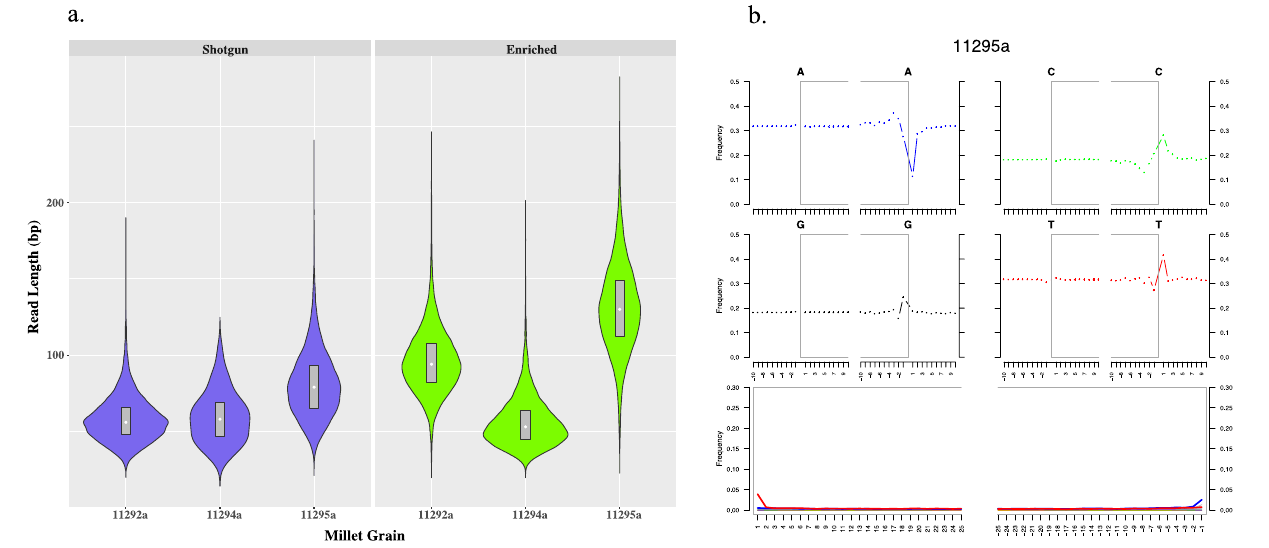
Figure 4. Read length distribution and mapDamage analysis. ( a ) Read length distributions of the shotgun and cpDNA enriched libraries made from three Areni-1 millet grains. All libraries were mapped to the Panicum miliaceum chloroplast reference genome: Genbank# KU343177.1. The shape of the violin displays the frequency distribution of the read lengths in each library. Inside each violin, the grey rectangle represents the interquartile range of the read lengths, while the white circle is the median 87 . ( b ) The nucleotide damage pattern of the cpDNA enriched library from the 11295a grain was assayed using mapDamage 2 31 . The enriched library exhibited the C → T nucleotide misincorporations pattern typical of authentic aDNA. The cpDNA libraries from grains 11292a and 112924a gave similar results and are presented in Fig.